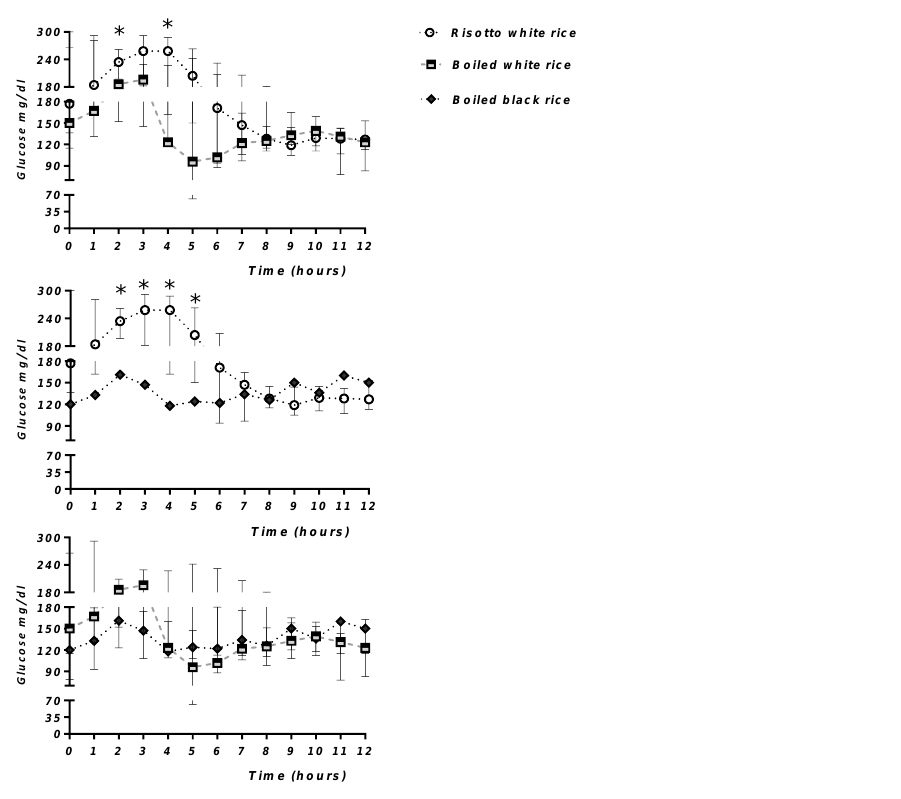
Figure 1. Glycemic trends after consumption of risotto white rice, boiled white rice, and boiled black rice over the following 12 h. * p < 0.05.